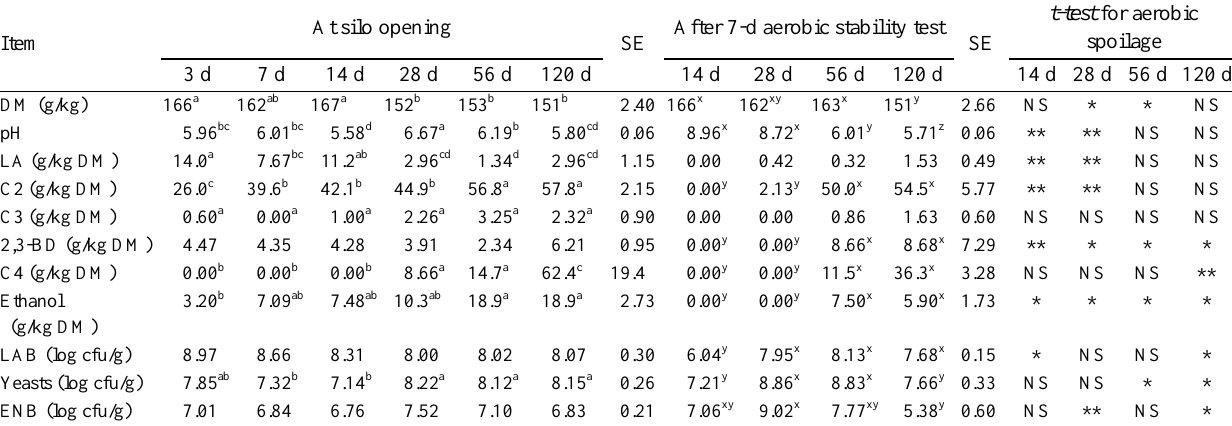
At silo opening